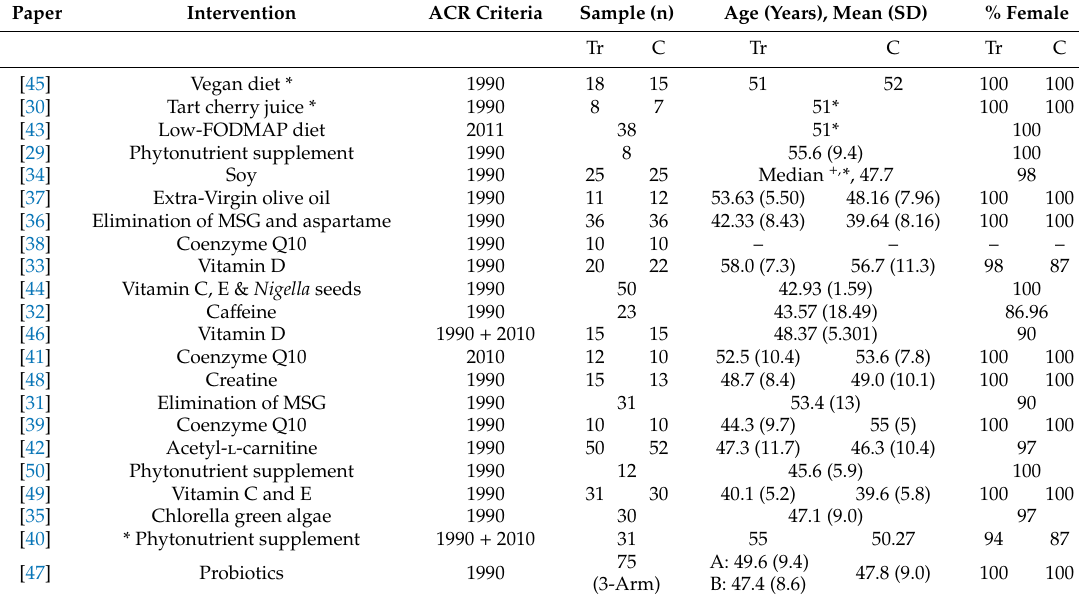
Table 2. Participant Baseline